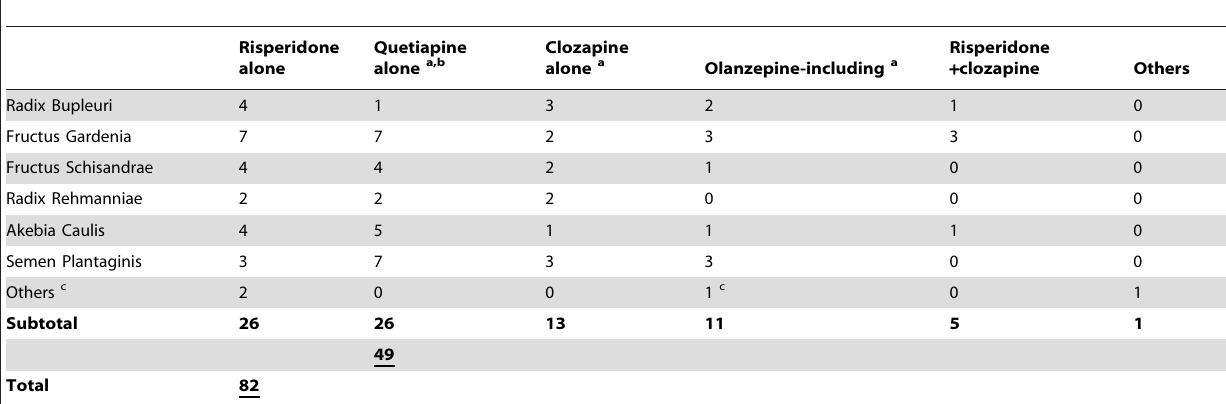
Table 6. Frequency distribution of herbal and antipsychotic concomitant treatment regimens associated with adverse outcome in schizophrenic